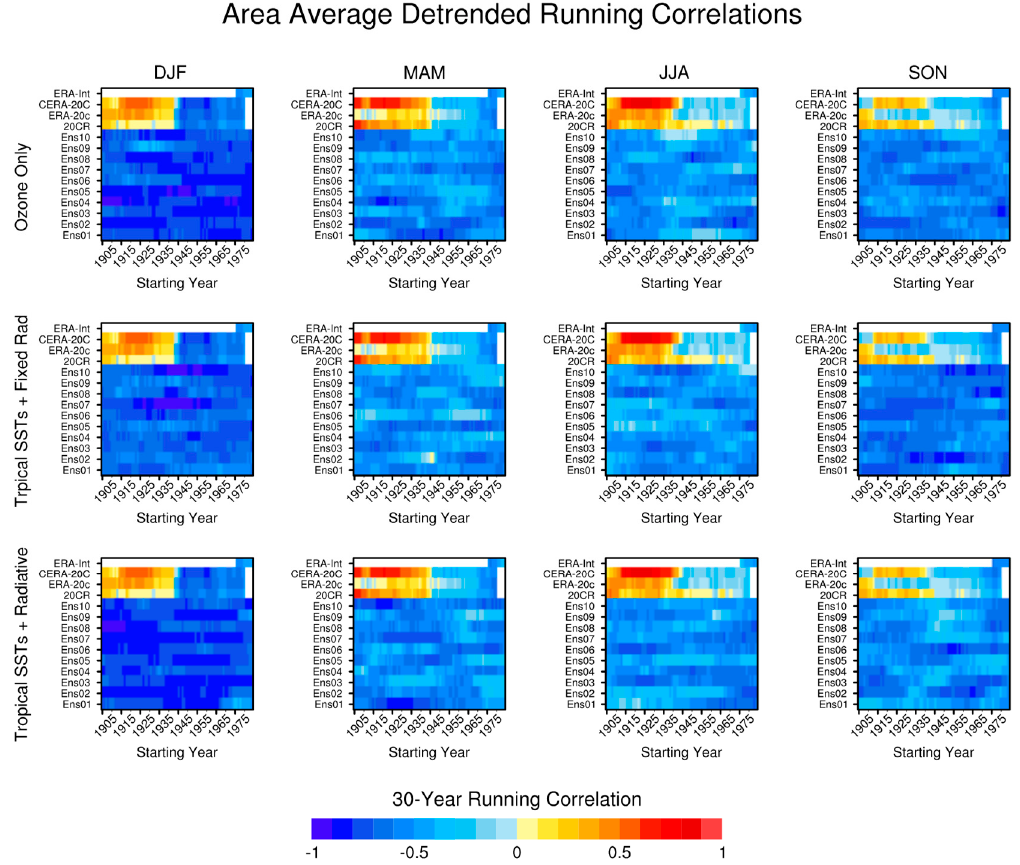
Figure 5. 30-year running area-averaged pressure correlations between 35–60 ◦ S and 60–90 ◦ S for CAM5, ERA-Interim and three century-length reanalyses (CERA-20C, ERA-20C and 20CR). Correlations were done for each CAM5 experiment by ensemble members within each. ERA-Interim does not begin until 1979 and the other century-length reanalyses 30-year trends end in 1980. All reanalysis data were detrended prior to calculating the correlations.